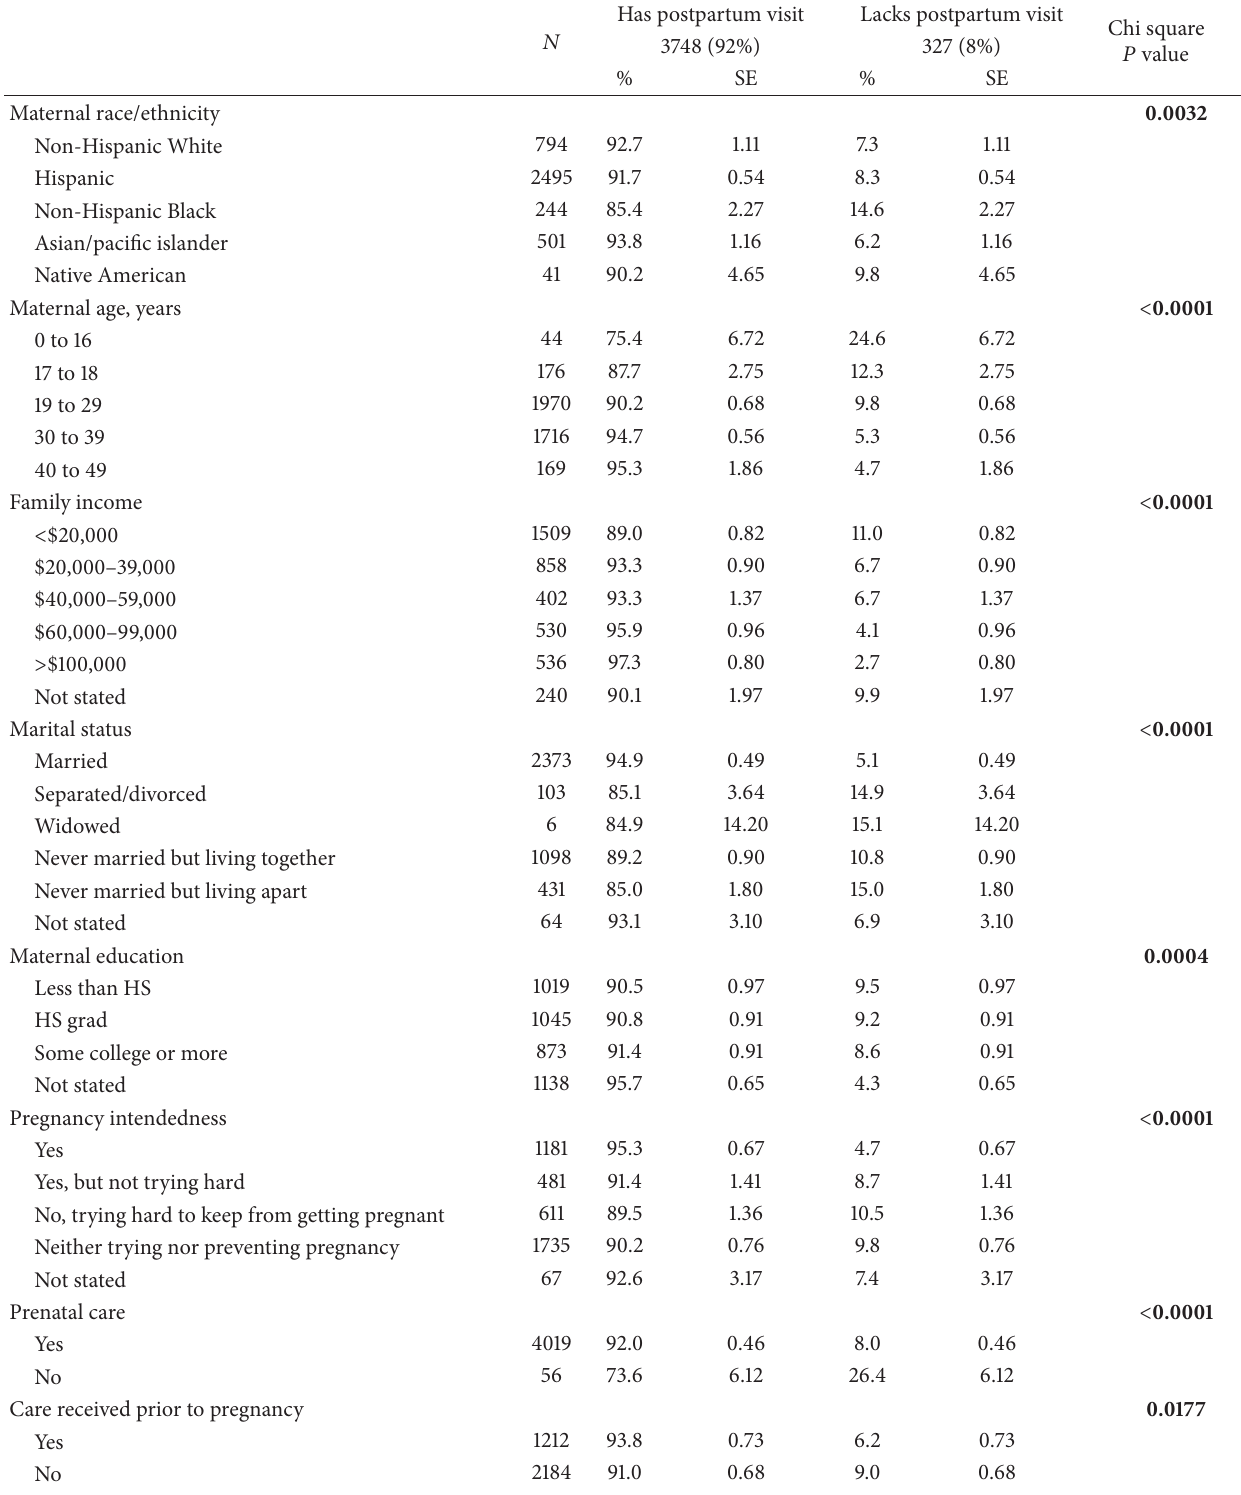
Table 2: Maternal demographic and socioeconomic characteristics by postpartum visit status. 2007